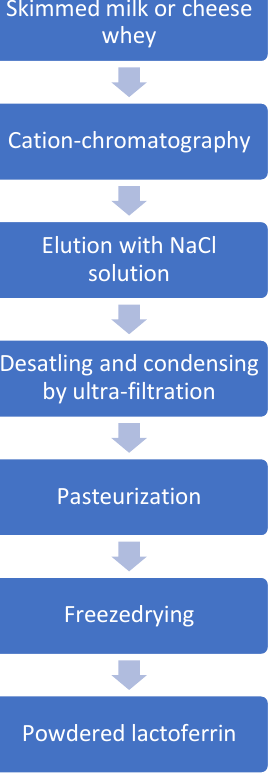
Figure 3. LF production process.